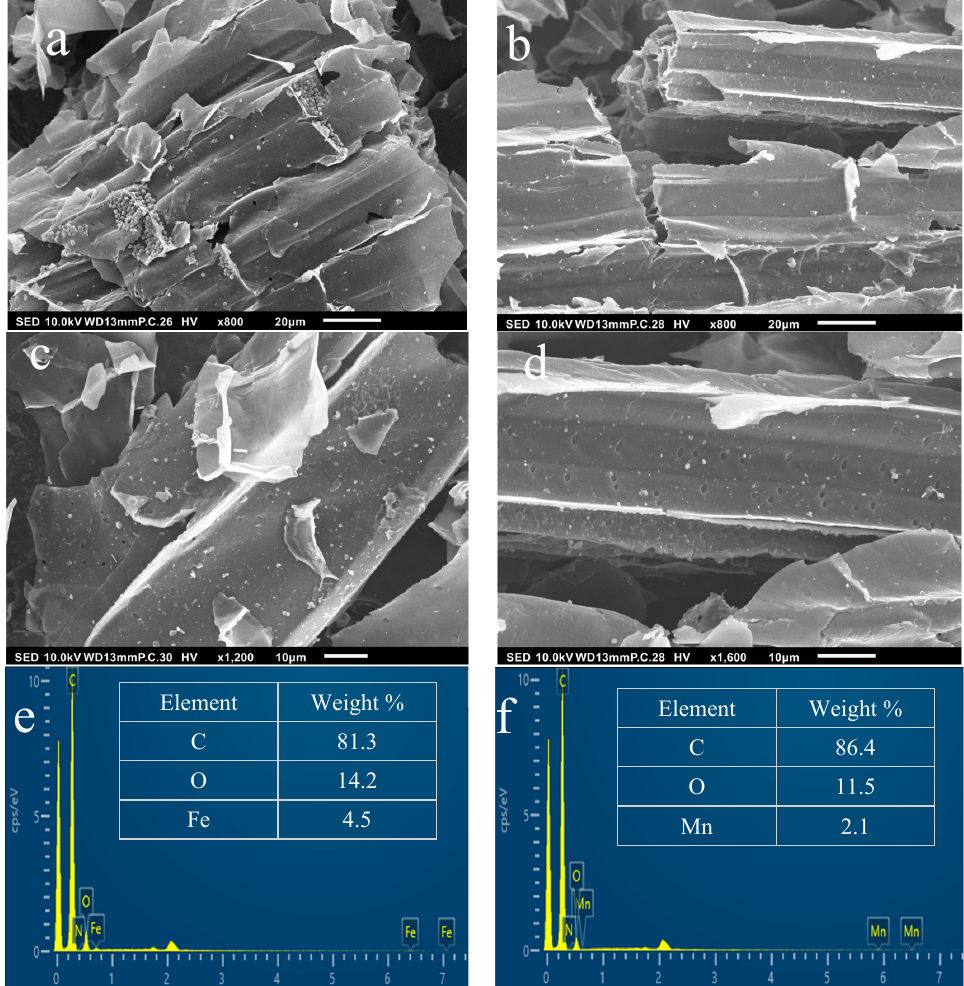
Figure 4. SEM images of catalytic biochar ( a , c ) SCB550-Fe and ( b , d ) SCB550-Mn at 800 × and 1600 × magnifications. EDS analysis of ( e ) SCB550-Fe and ( f ) SCB550-Mn.